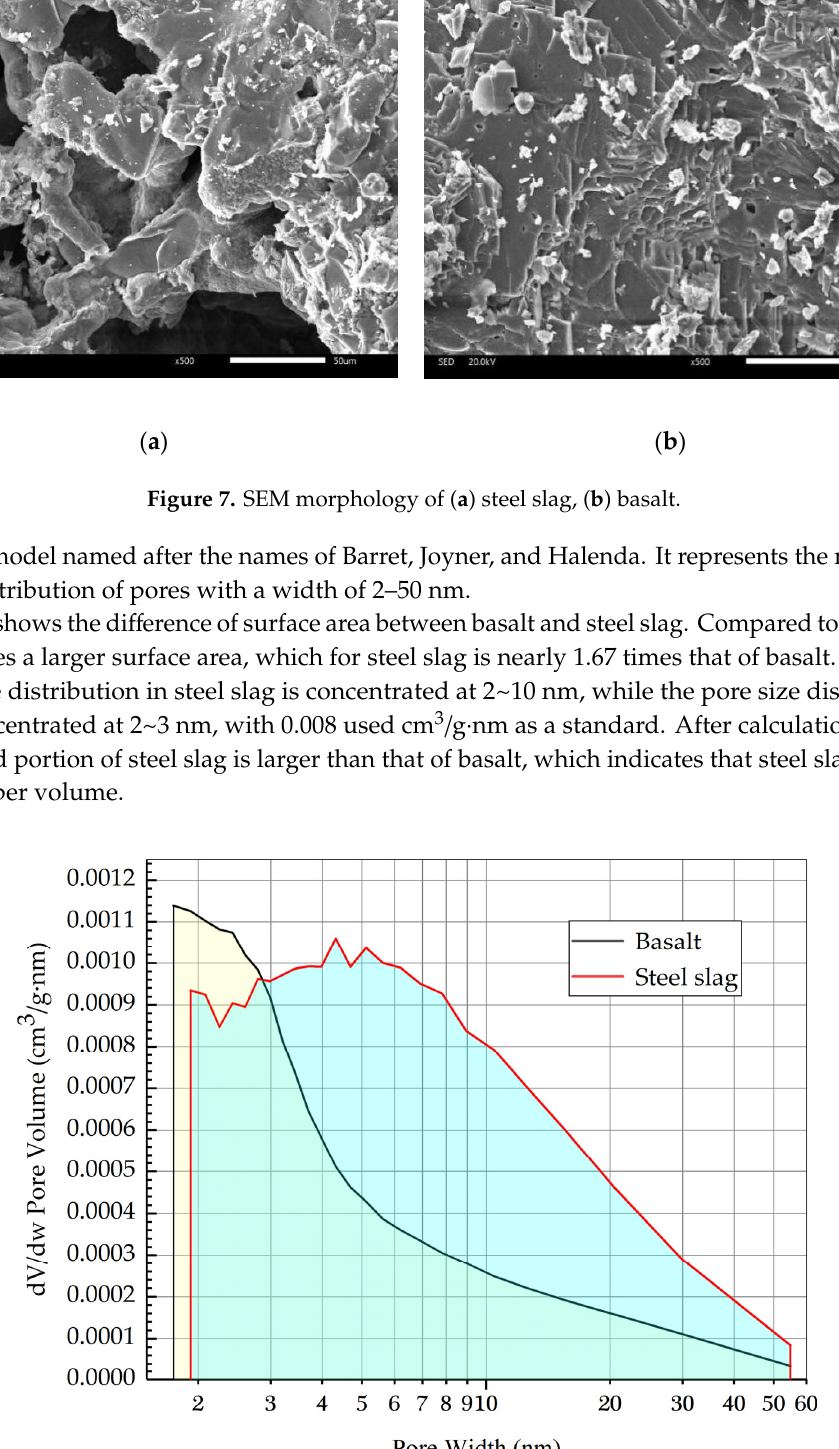
Figure 8. BJH adsorption dV / dw pore Figure 8 BJH adsorption dV/dw pore volume. Table 3 Surface area of basalt and steel slag.